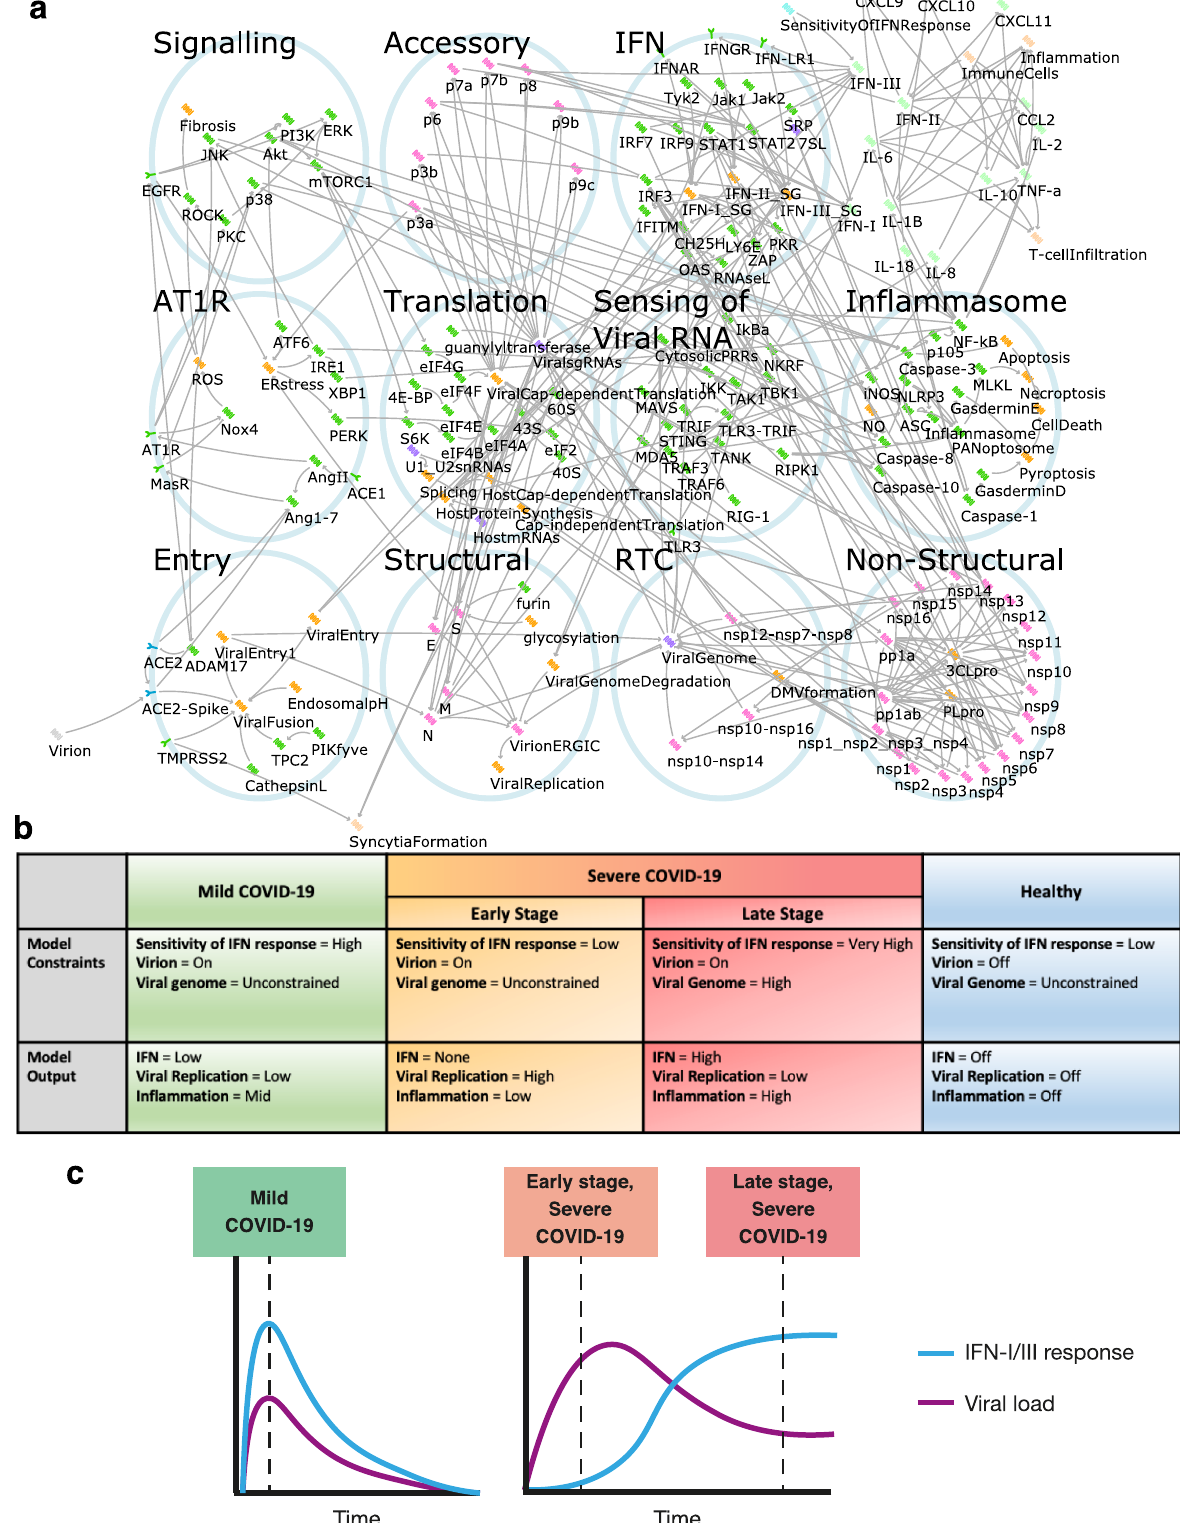
Fig. 2 Computational modelling of host – virus interaction in COVID-19. a The SARS-CoV-2 infection signalling network as modelled in the BioModelAnalyzer tool. Viral proteins depicted in pink, host proteins depicted in green, cellular processes depicted in orange, RNAs depicted in purple. Activating interactions are represented by arrows ( → ), inactivating by bars ( ⊣ ). b Description of the model constraints and outputs for the three states of the disease and the control healthy state. c Trajectories of IFN – I/III response and viral load in mild and severe COVID-19 (as described in Park and Iwasaki, Cell Host and Microbe , 2020) were used to inform the